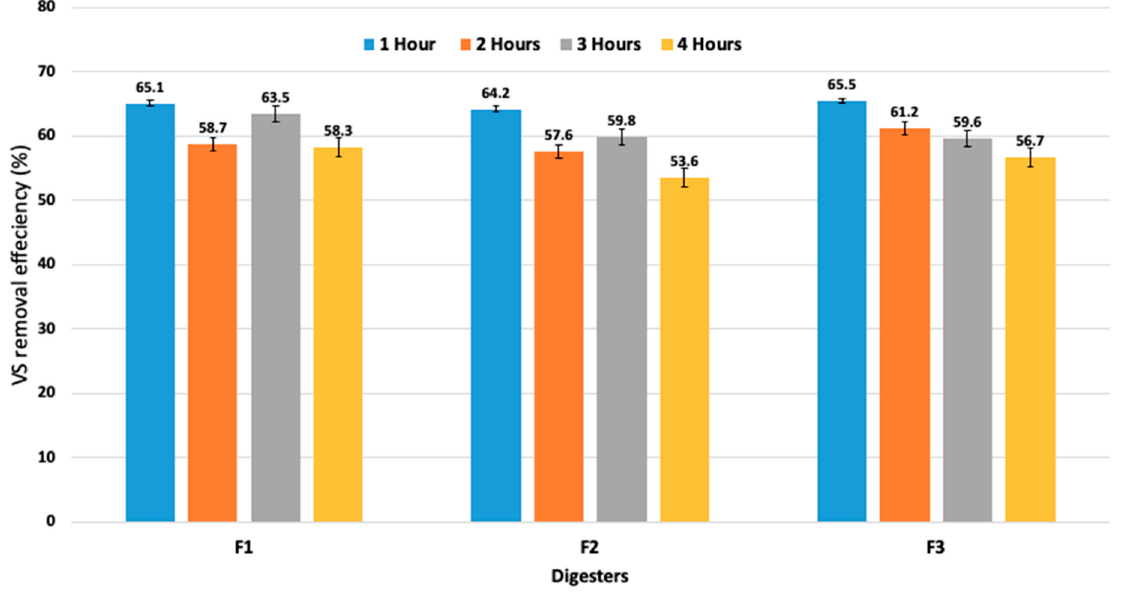
Figure 4. Performance of all three anaerobic digesters for total volatile solids removal with different mixing intervals at 67 rpm. Table 3. Statistical analysis of biogas production at various resting times during mixing. Table 4. Represents the total VS reduction (%) in all the digesters at various mixing